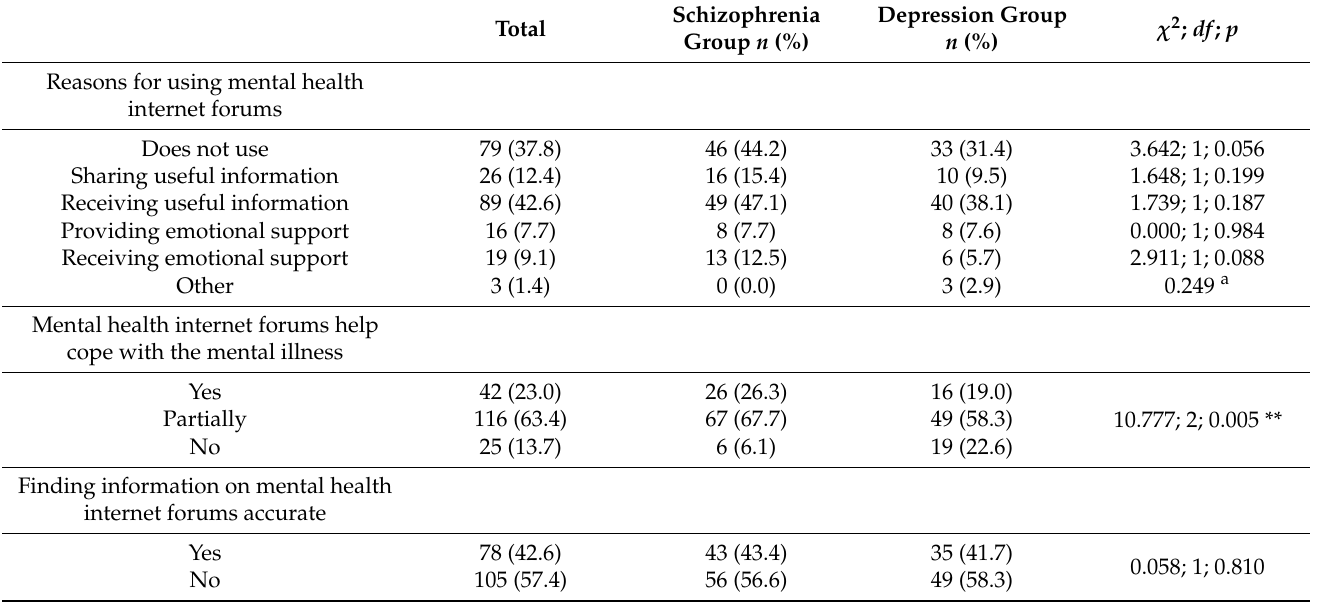
Table 9. Mental health internet forums